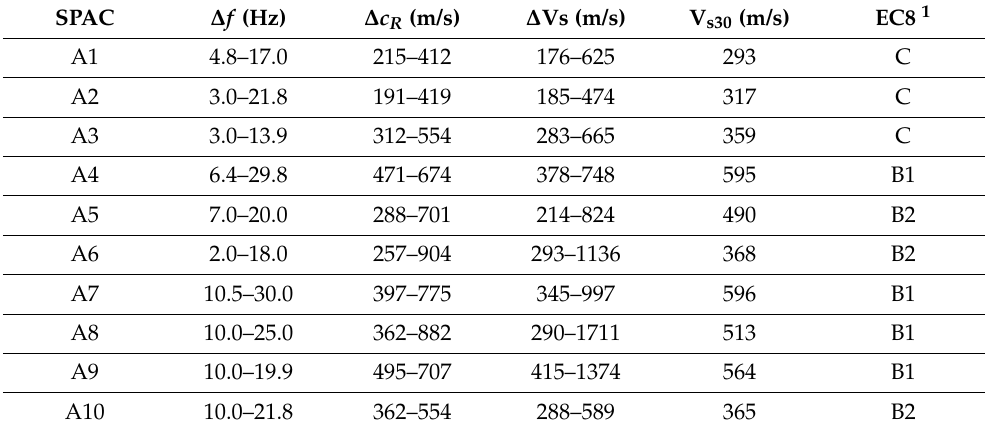
Figure 6. Examples of shear-wave velocity models derived from inversion of phase velocities determined from SPAC measurement at different places (see location in Figure 2). Initial model (yellow line), partial models obtained during the inversion process (black lines), and final model (red line) are shown. ( a ) A2 site (flood plain); ( b ) A8 site (hill with gentle slope). Table 1. Summary of V s30 values measured using the SPAC technique. In addition, equivalence with the EC8 classification is provided, including the internal division of B ground